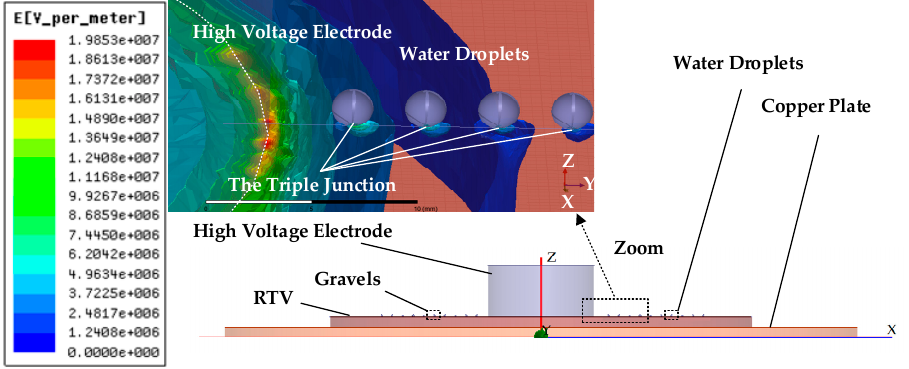
Figure 12. The distribution of electric field after applying droplets (gravels).